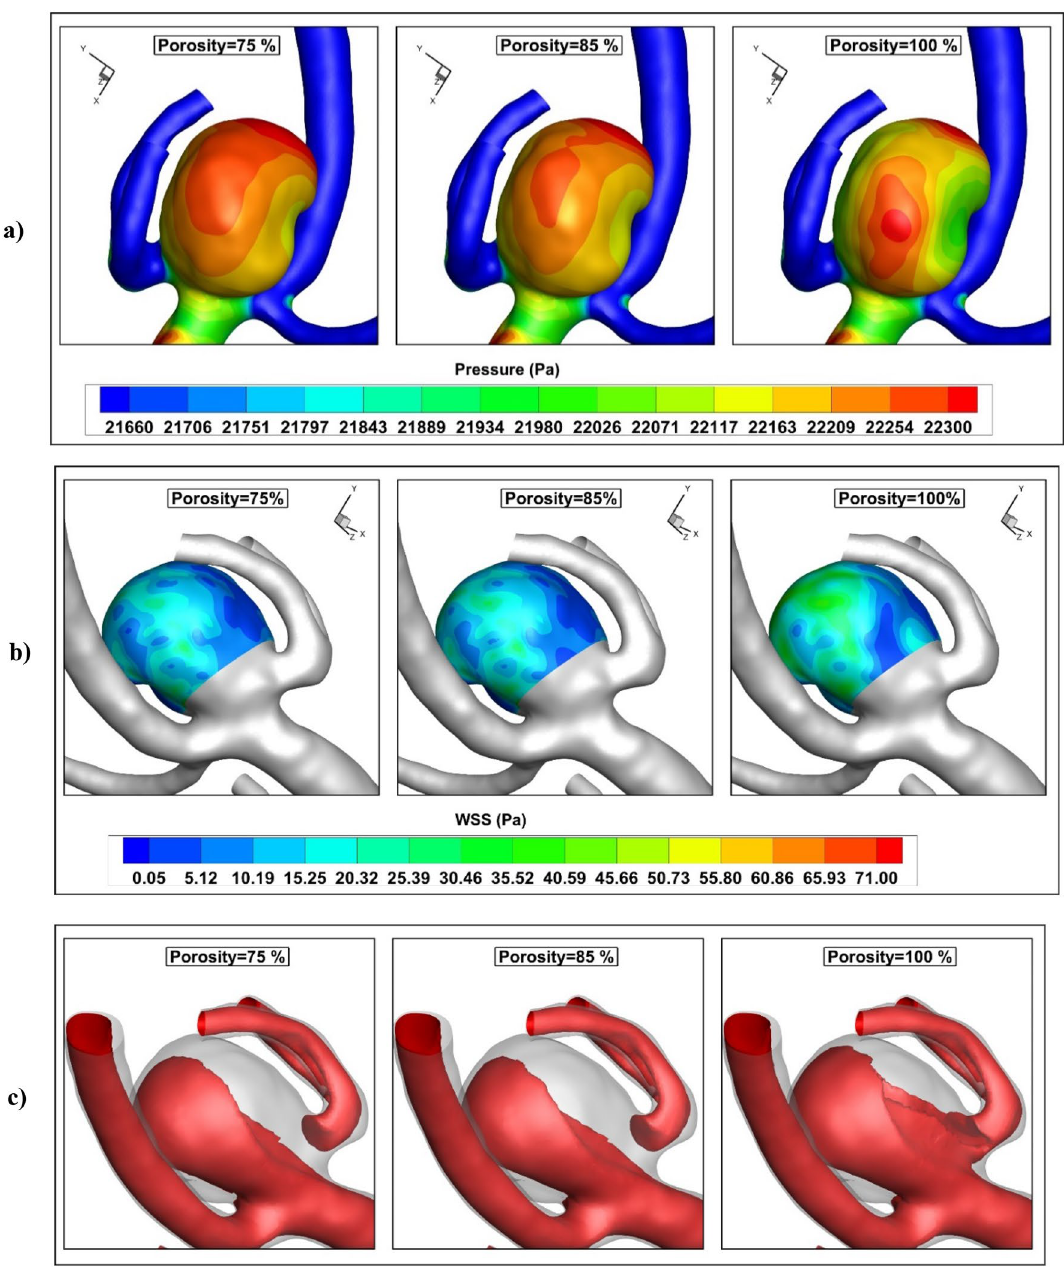
Figure 10. Influence of coiling porosity on ( a ) pressure ( b ) AWSS ( c ) iso-velocity (v = 0.6 m/s) contour at peak